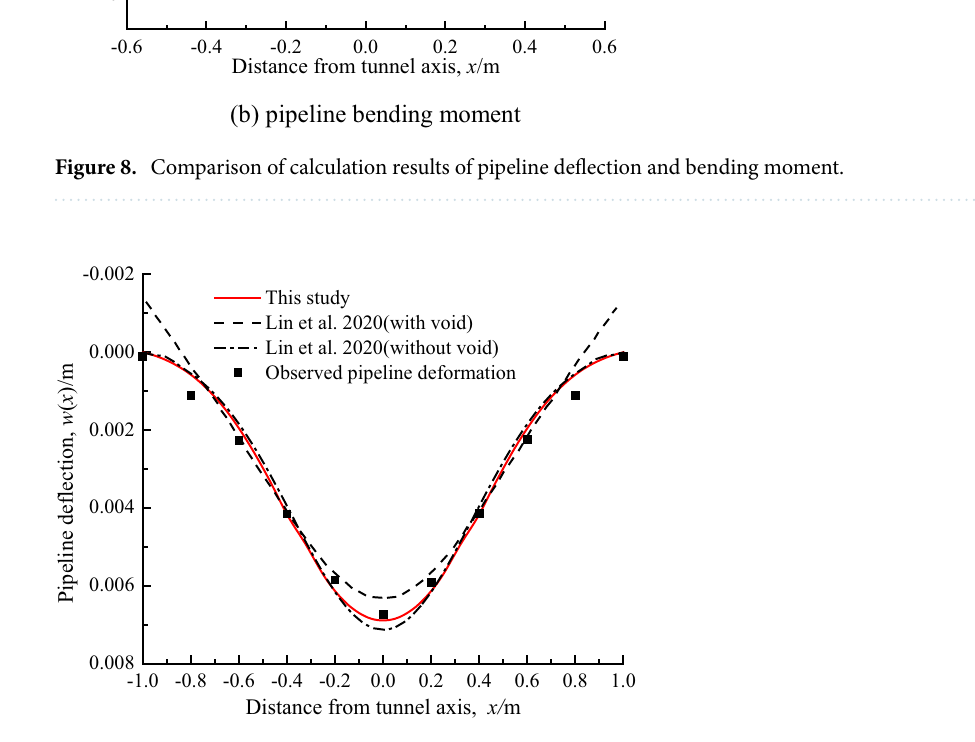
Figure 9. Comparison of calculation results of pipeline